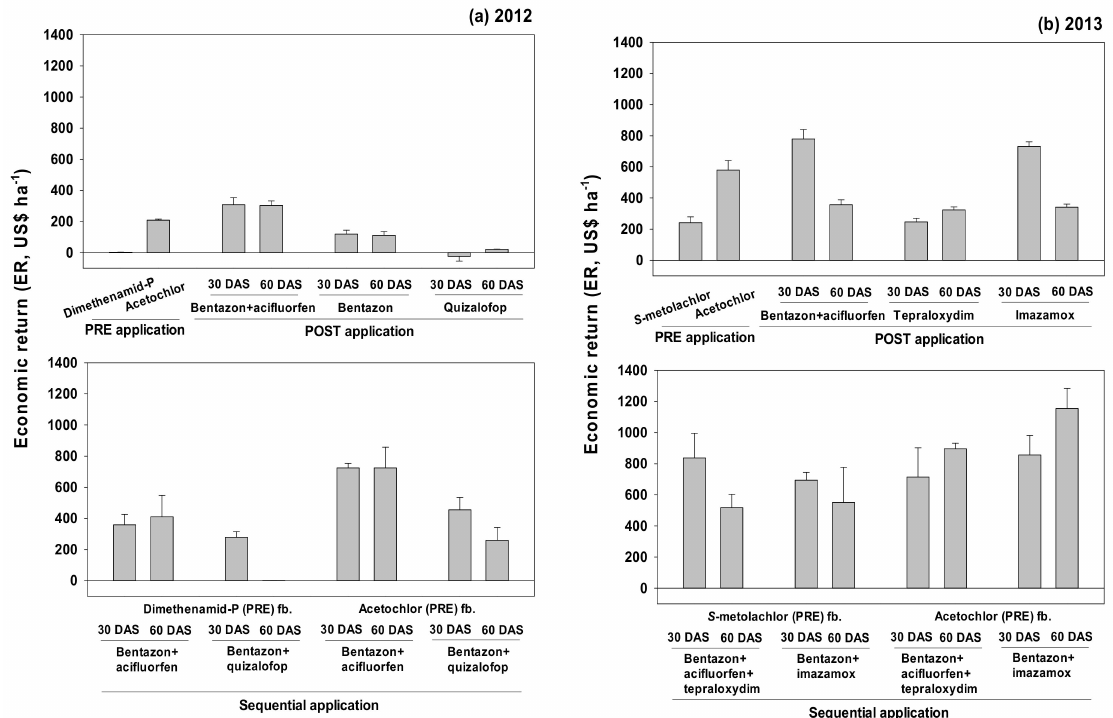
Figure 4. Economic analysis of sequential PRE and POST herbicide applications in comparison with acetochlor (PRE) and bentazon + acifluorfen (POST) sole applications in 2012 ( a ) and 2013 ( b